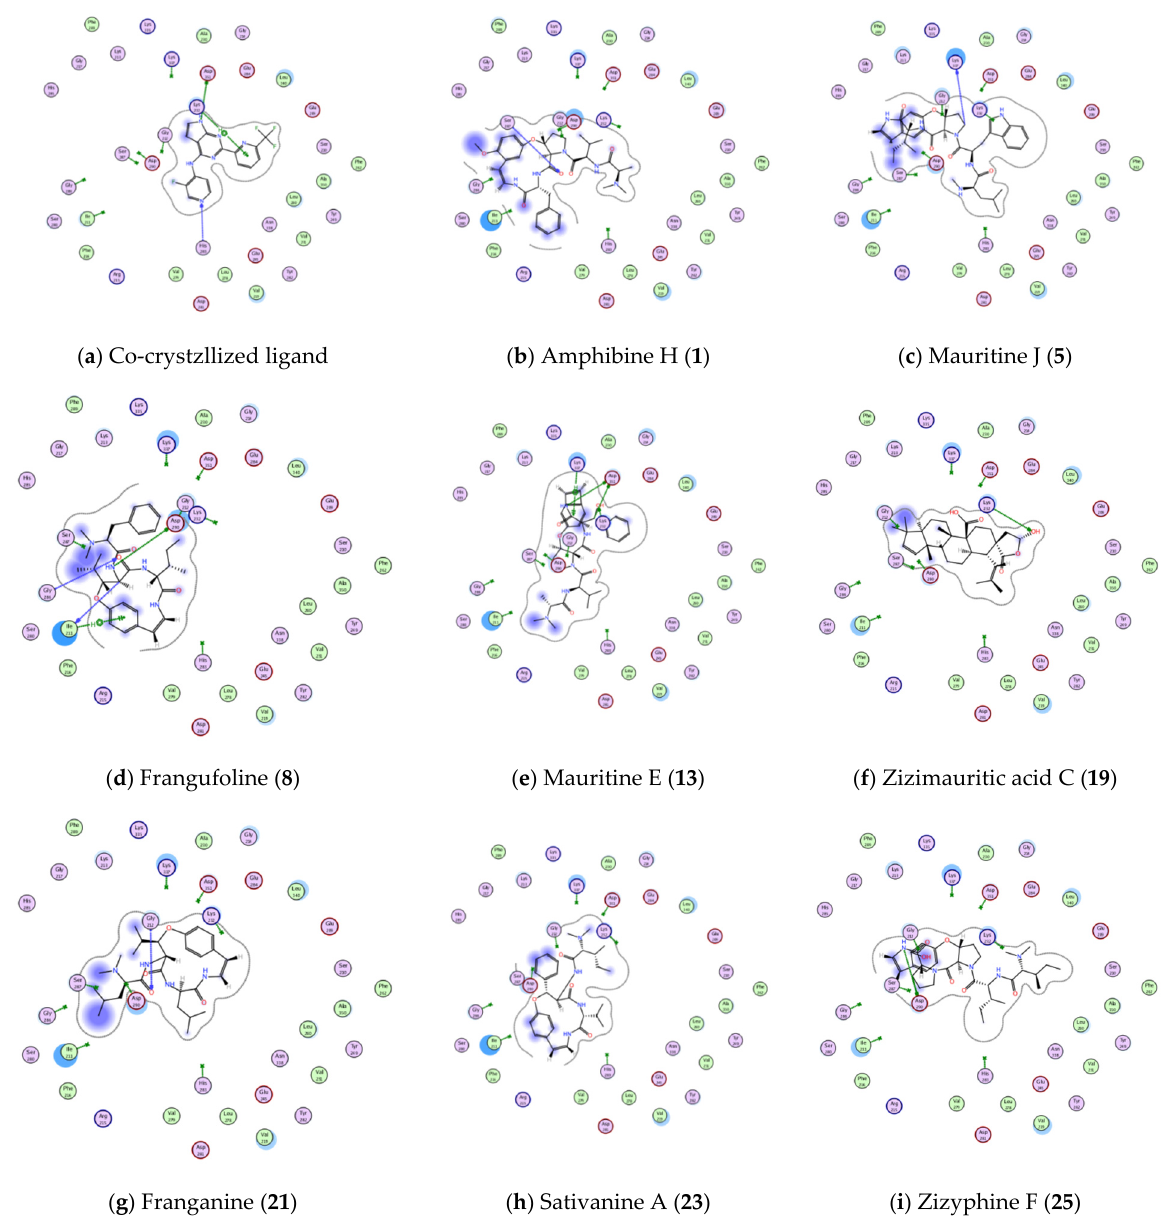
Figure 12. Showing 2D-binding interactions of co-crystallized ligand ( a ) and molecules 1 , 5 , 8 , 13 , 19 , 21 , 23 , 25 ( b – i , respectively) within active sites of TGFBR1 kinase (PDB ID: 6B8Y). Finally, docking poses within Interleukin 1 beta (1L b PDB ID: 6Y8M, resolution 1.9 Å) active site showed better and promising results more than previous active sites; 12 molecules showed better binding scores than co-crystallized ligand (> − 4.2536 kcal/mol, Table 5). Out of these 12 molecules, 8 molecules succeed to show strong bonding interaction within 6Y8M active site (ash shown in Figure 13 and Table 5). In short, the binding modes and free energies obtained for the isolated compounds during the molecular docking studies within active sites of TGFBR1, TNF- α , and IL-1 β confirm in-vivo animal studies results, which manifested by the significant change in the mRNA expression of TGF- β (increased) and the inflammatory markers, TNF- α and IL-1 β ) (decreased), as shown in Table